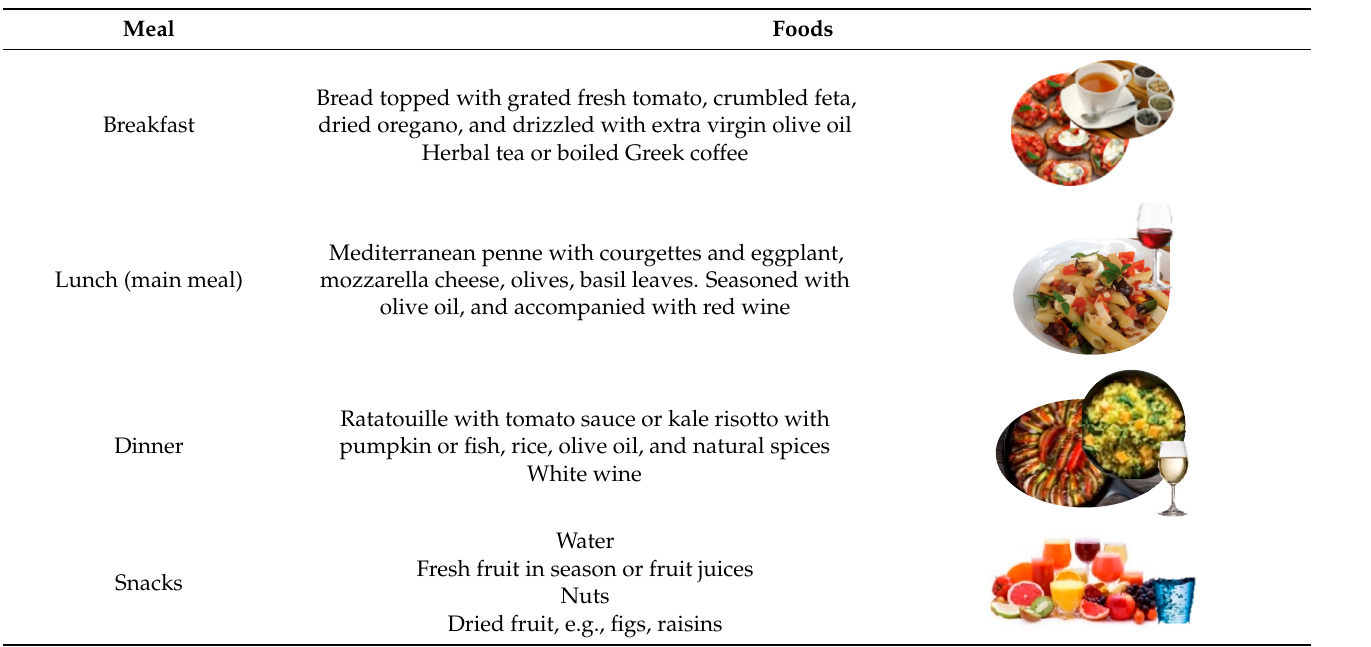
Table 3. One-day menu sample of the Mediterranean diet. Adapted from Radd-Vagenas et al. [33]. Meal Breakfast